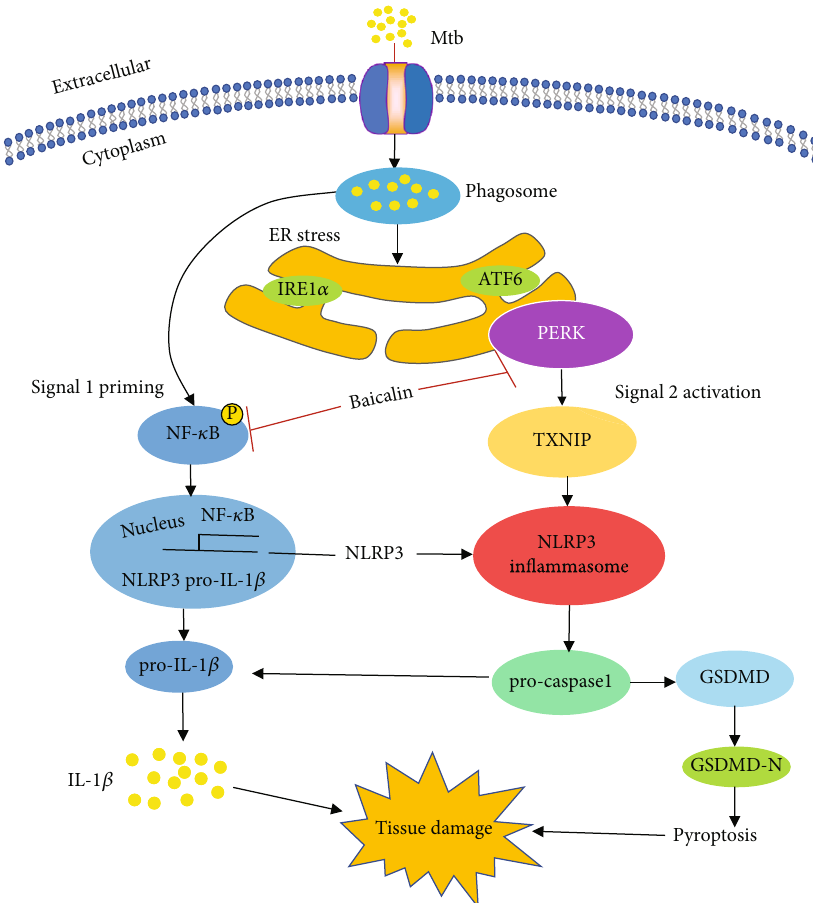
Figure 7: Schematic summary of baicalin inhibiting pyroptosis in Mtb-infected macrophages. Previous study has revealed that baicalin inhibits the NF- κ B pathway contributing to the inhibitory e ff ect on NLRP3 in fl ammasome activation [9]. In the present study, we demonstrated that baicalin also inhibits the activation of the PERK pathway, thus attenuating the production of TXNIP and subsequently alleviating the activation of NLRP3 in fl ammasome resulting in ameliorating pyroptosis in Mtb-infected